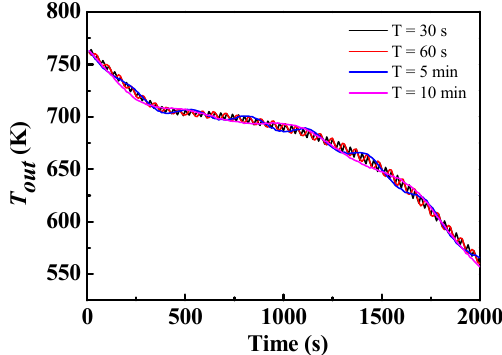
Figure 16. Time evolution of the outlet temperatures at different periods ( T ) under the given inlet power